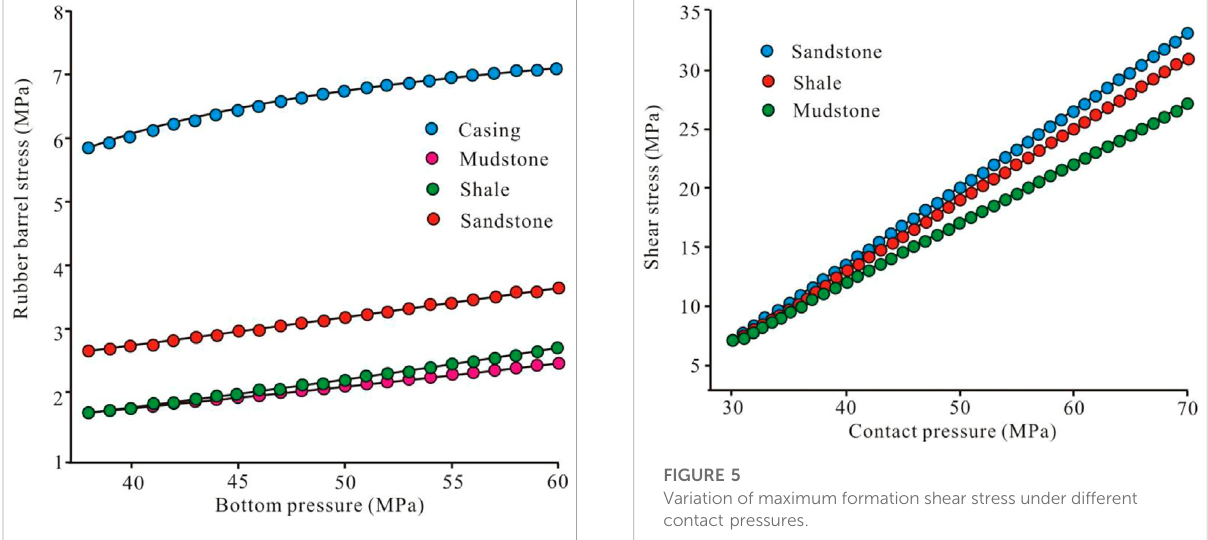
FIGURE 4 Variation curveof theisolation safety factor with the pressure under the rubber cylinder under different formation models.